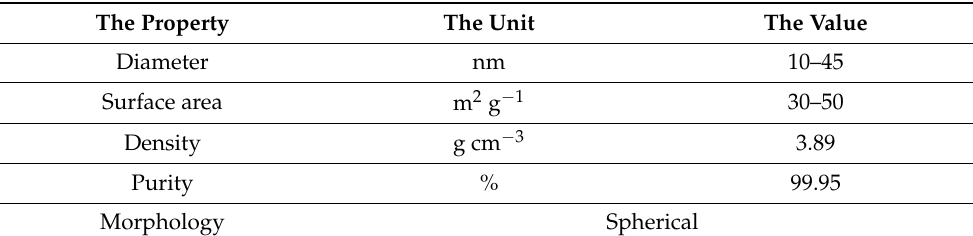
Table 2. Some major properties of the Se-NPs used in this